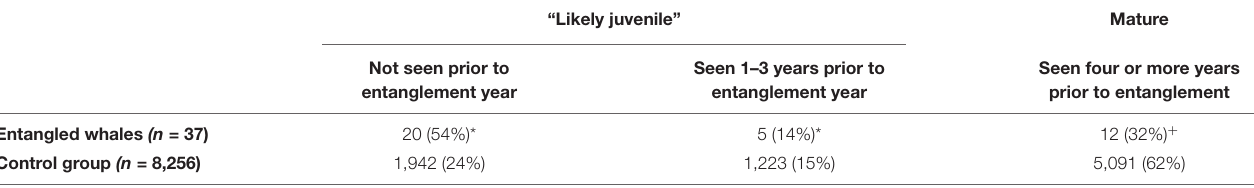
TABLE 2 | Sighting history as a proxy for age-class.